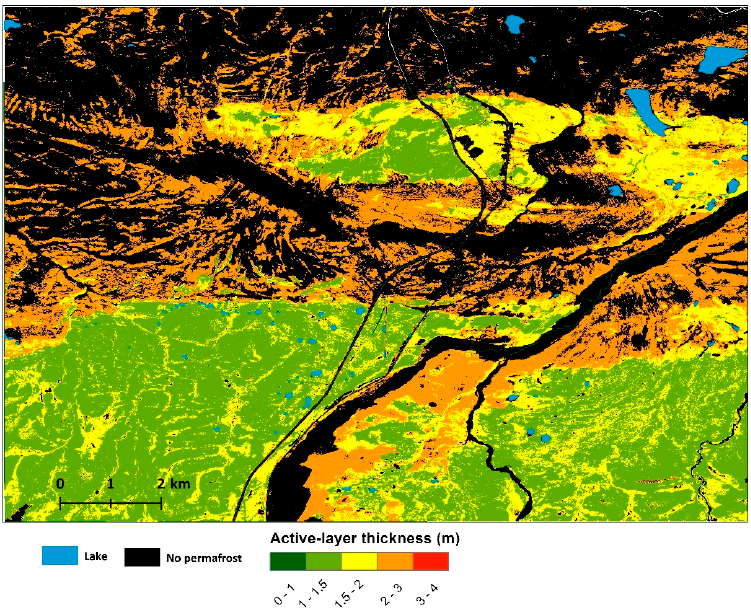
Figure 6. Modeled mean active-layer thickness for the period of 2006–2015.